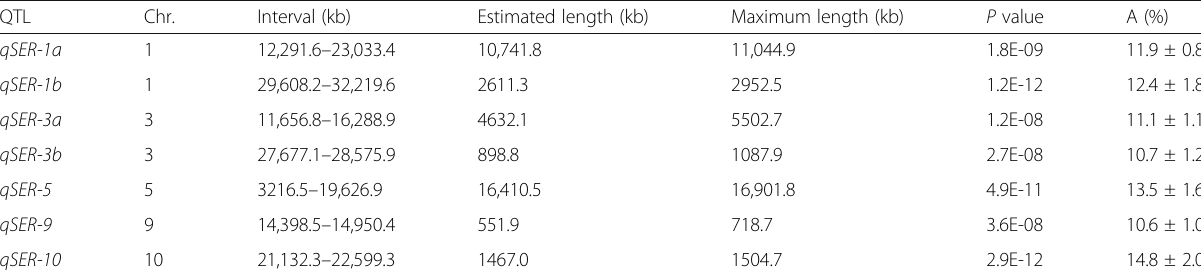
Table 1 Additive effects of QTLs for stigma exsertion rate detected in the SSSLs QTL